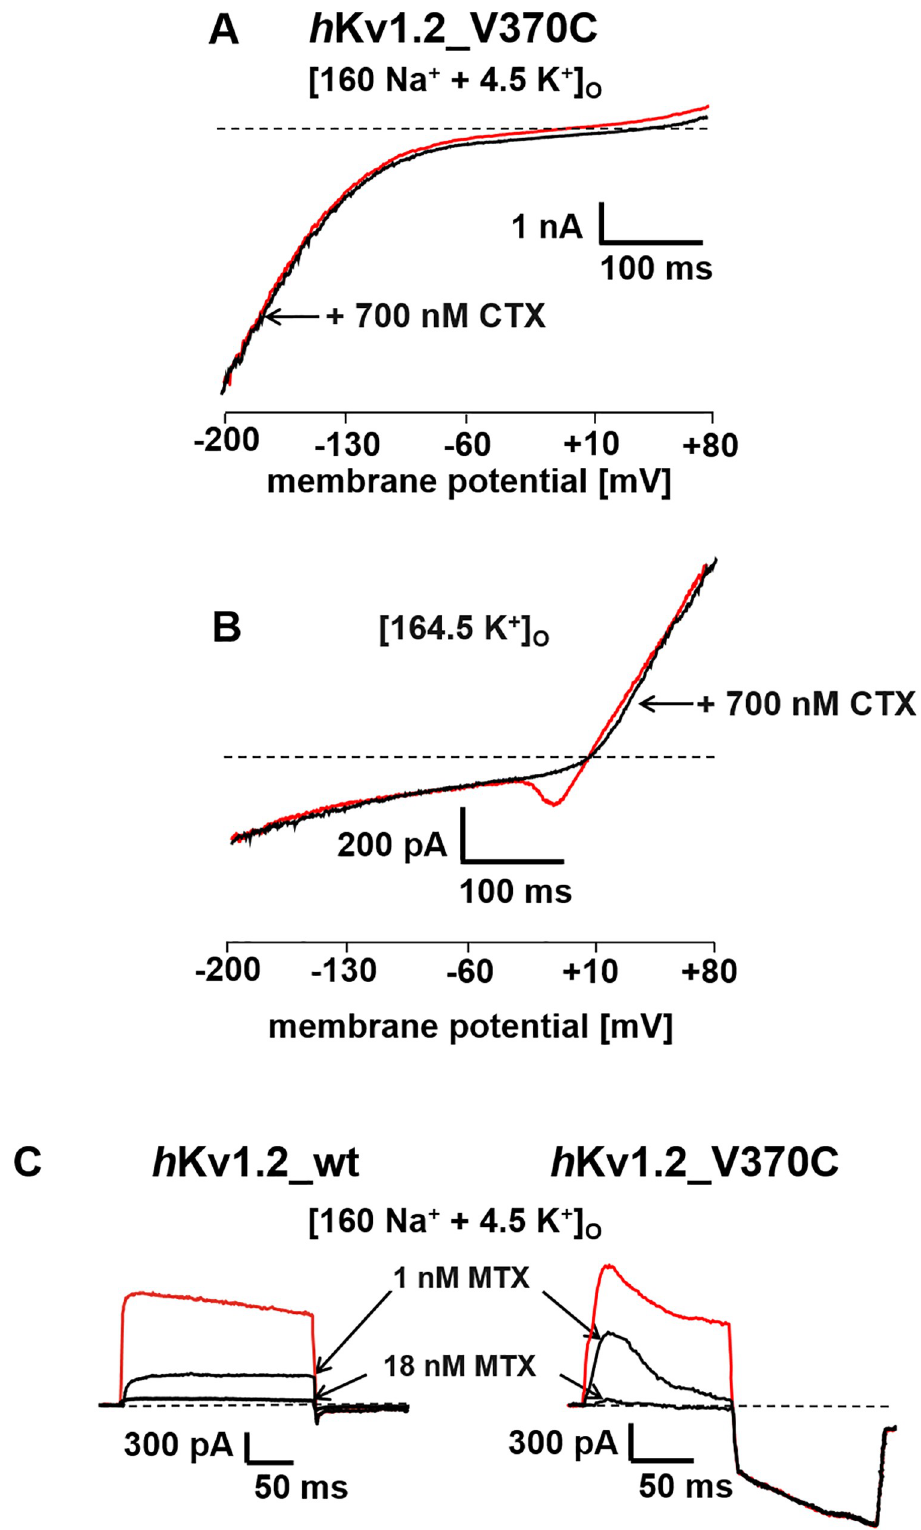
Fig 3. Effect of CTX and MTX on σ -currentin the h Kv1.2_V370C mutant channel. A and B ramp currents through the h Kv1.2_V370Cmutant channelsin [160 Na + + 4.5 K + ] o ( A ) and in [164.5 K + ] o ( B ) bath